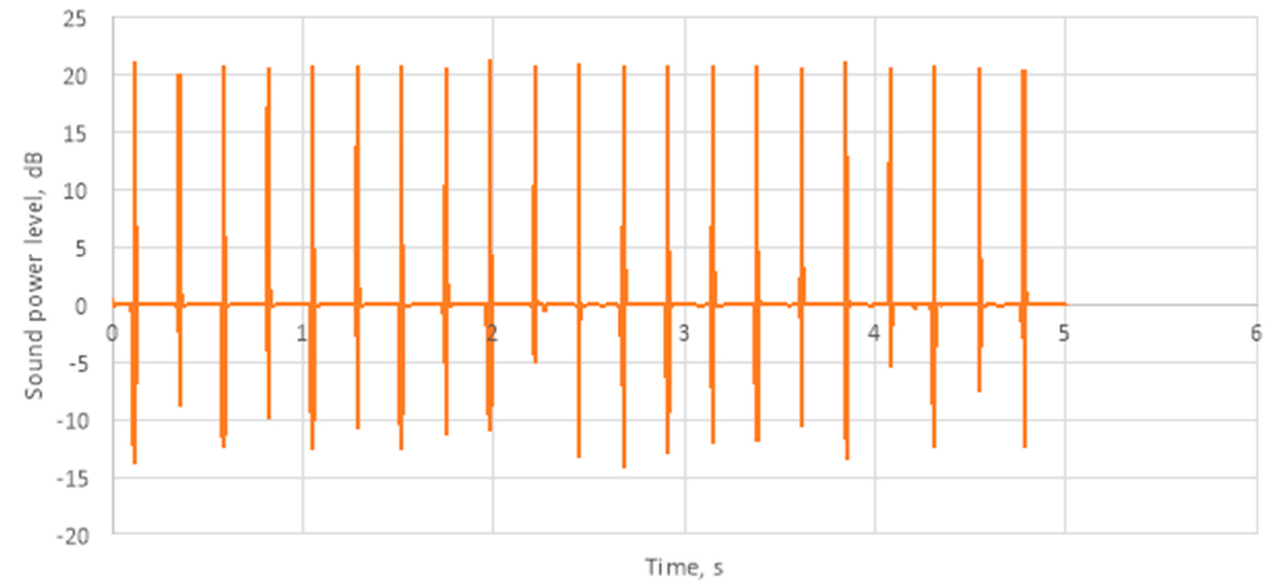
Figure 14. Calculated sound power level values of the 71st wheelset.